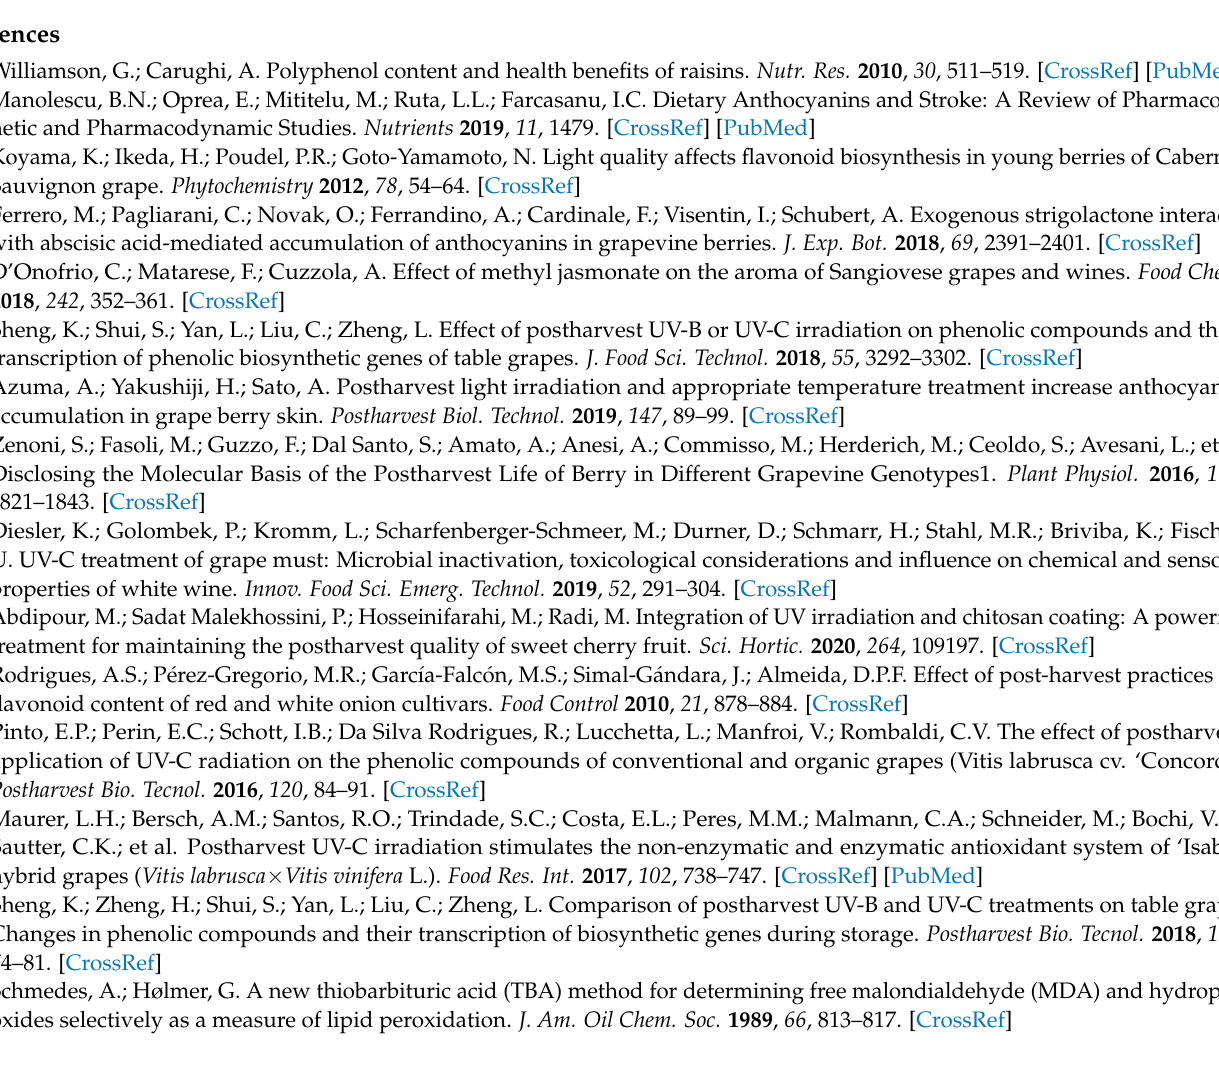
UV-C exceeded 10 days. Table S1: General overview of transcriptome data. Table S2: Novel genes identified in the transcriptome. Table S3: List of primer sequences used in qPCR analysis. Table S4: General overview of metabolite data. Table S5: General overview of flavonoids. Table S6: Flavonoids with significant differences between different groups. Table S7: Top three differential metabolites between different